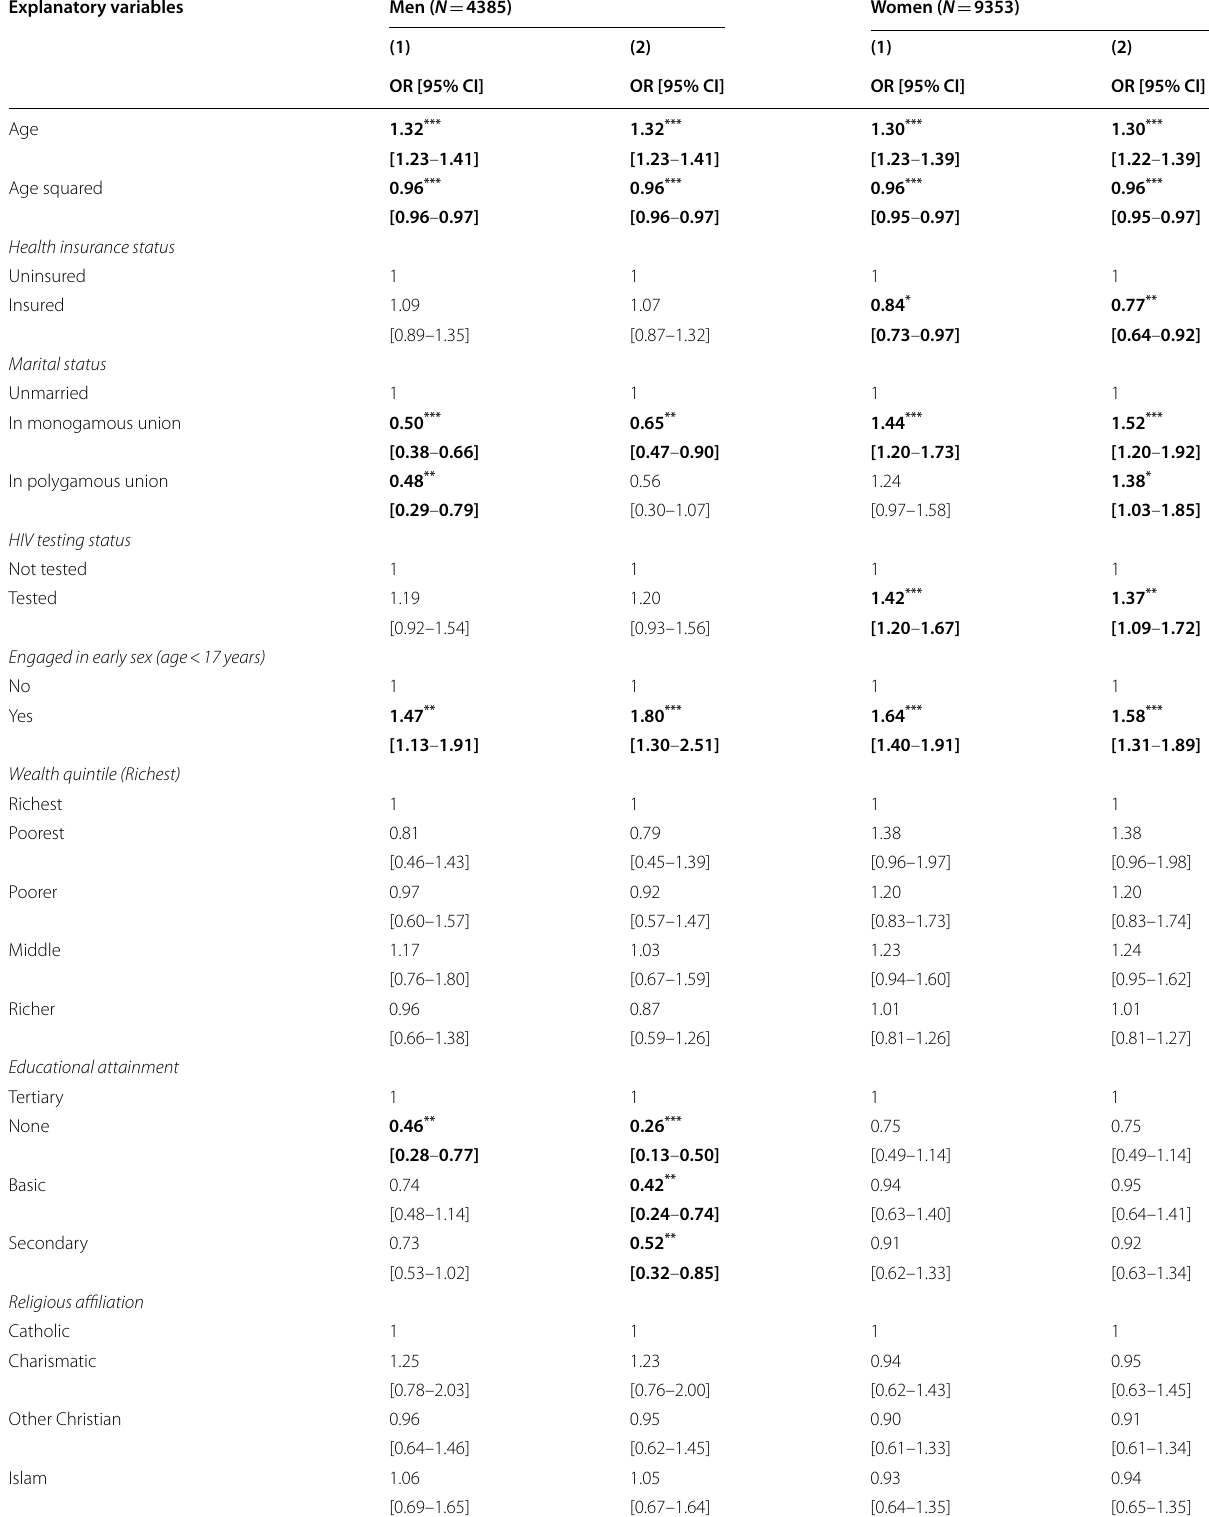
Table 4 Determinants of modern contraceptive